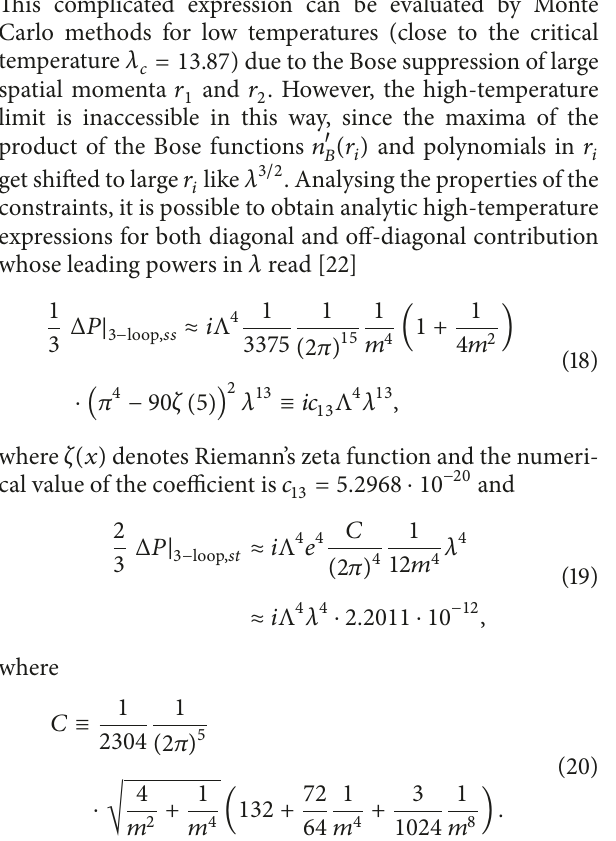
Figure 8: Monte Carlo results of Δ𝑃| 3− The solid line is a smooth interpolation of the latter while the dashed line represents |Δ𝑃| 2−